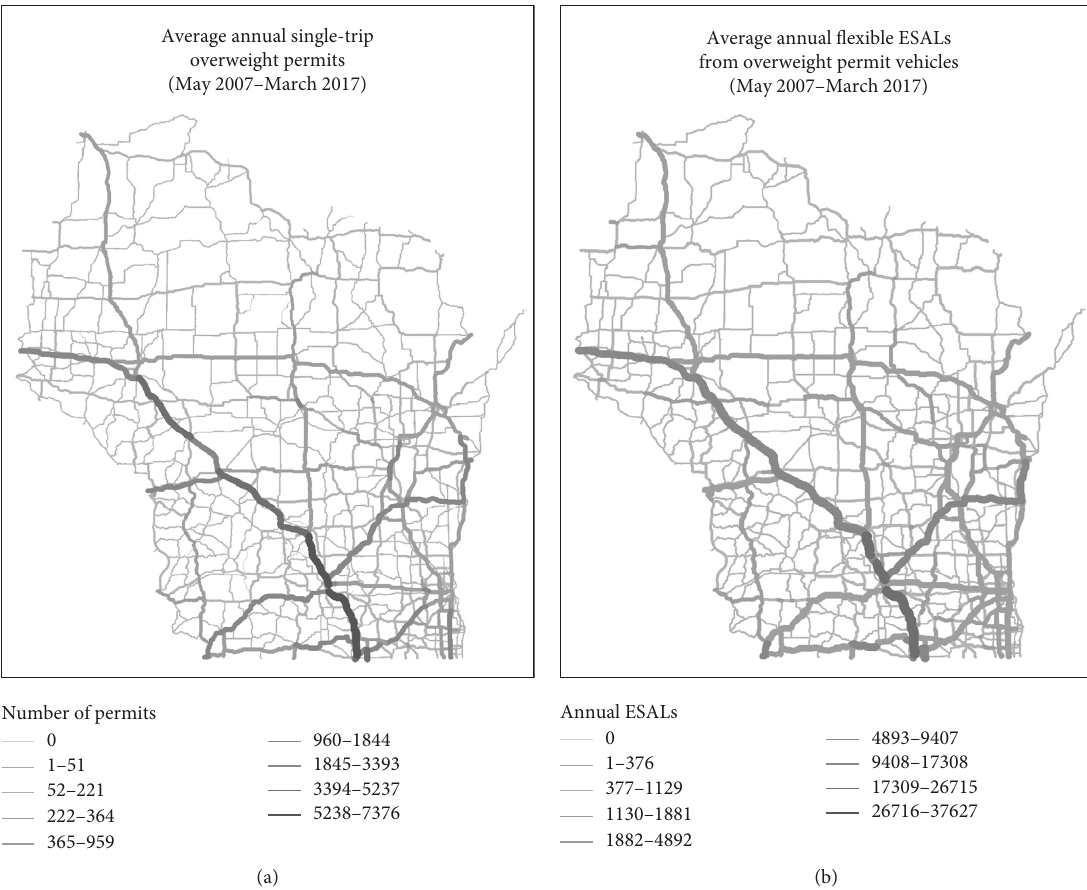
Figure 1: Statewide OW permit route analysis maps. (a) Map of OW permit frequency and (b) map of OW permit ESALs.